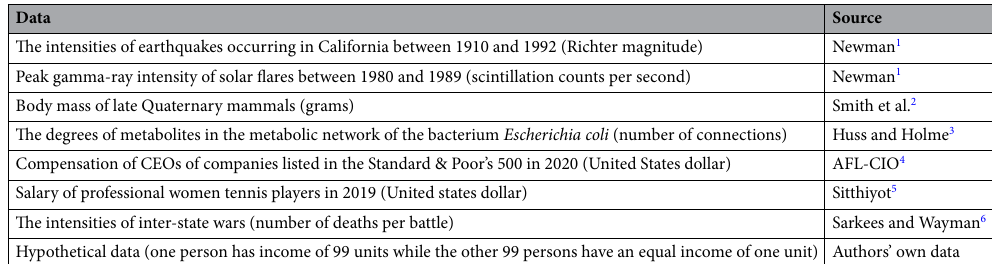
Table 1. The list of the data on sizes of events or things occurring in nature and society and the hypothetical data as well as their